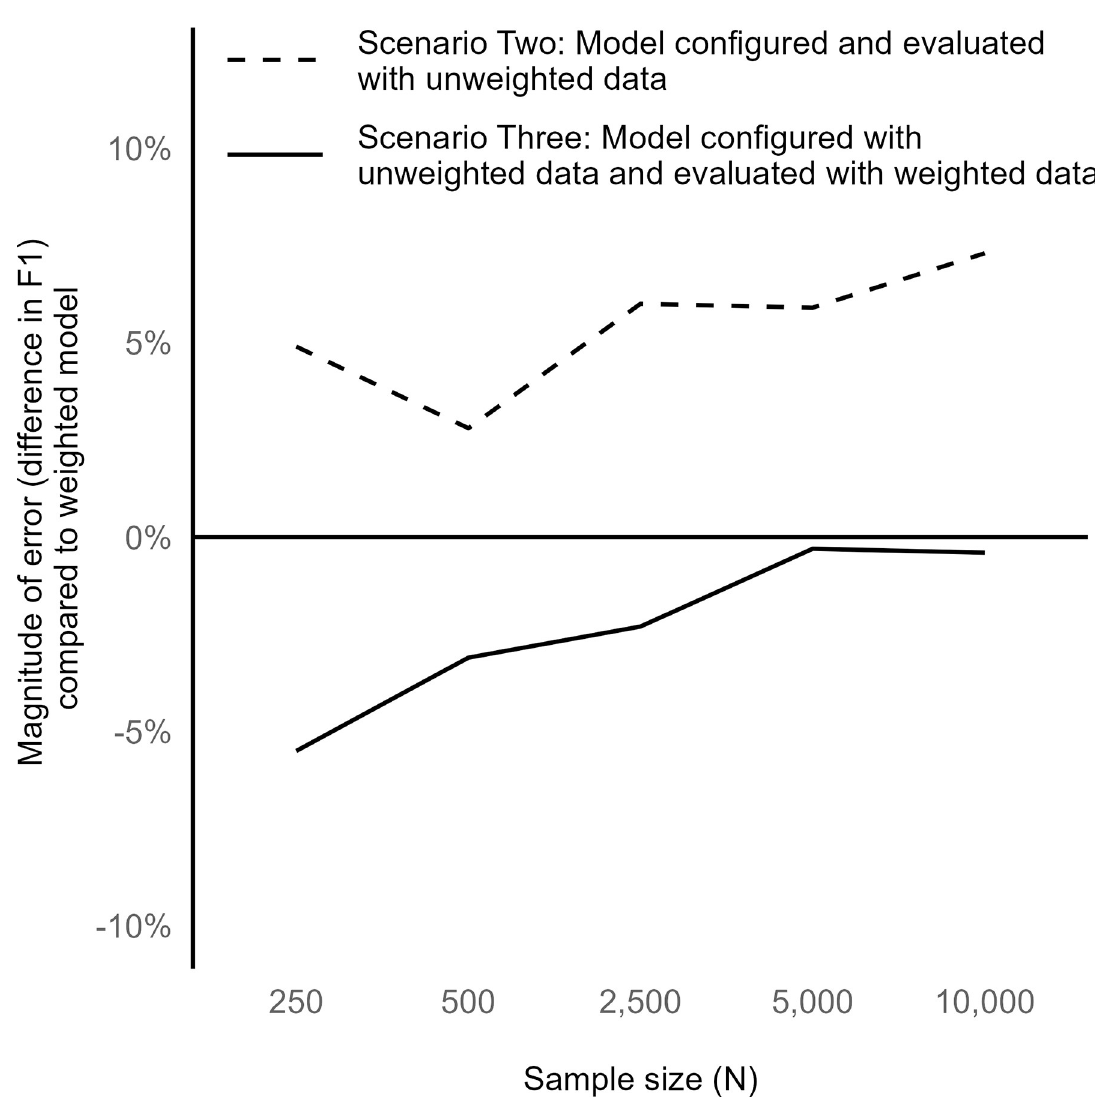
Fig 1. Performance of unweighted versus weighted gradient boosting model implementations by sample size (baseline